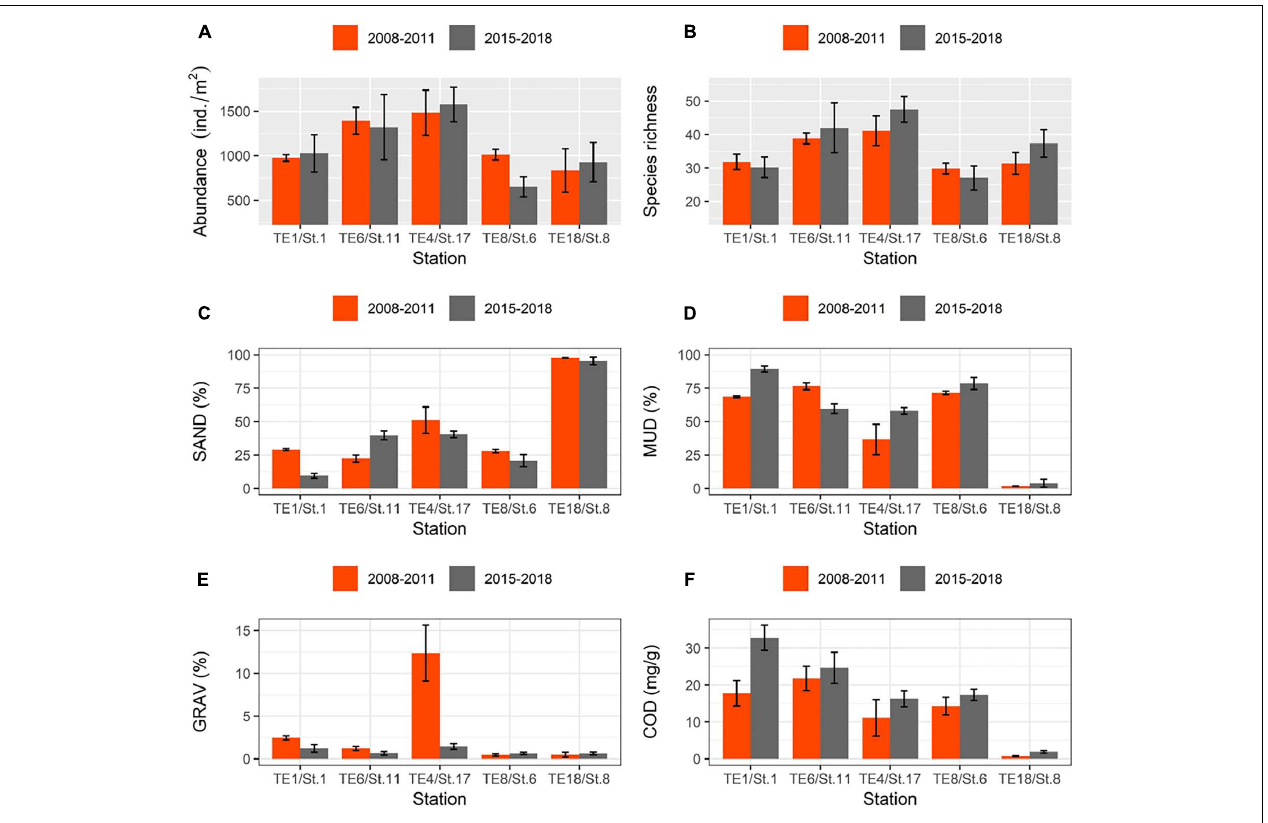
FIGURE 10 | Bar graphs showing changes in mean values ( ± SE) of selected macrofaunal and environmental data taken “before” (orange bars) and “after” (gray bars) the 2011 disaster: (A) abundance; (B) species richness; (C) SAND; (D) MUD; (E) GRAV; and (F) COD (coding of environmental variables as in Table 1